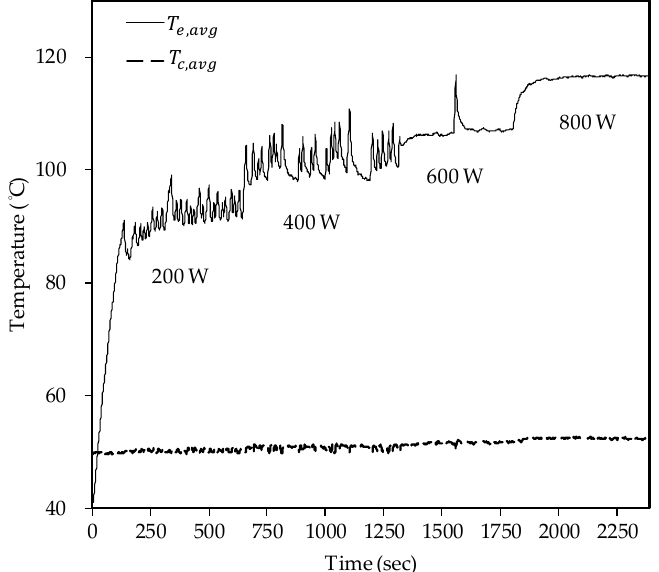
Figure 9. Average temperature variation vs. time for input power 200 W to 800 W; anti-gravity condition (top heating mode).